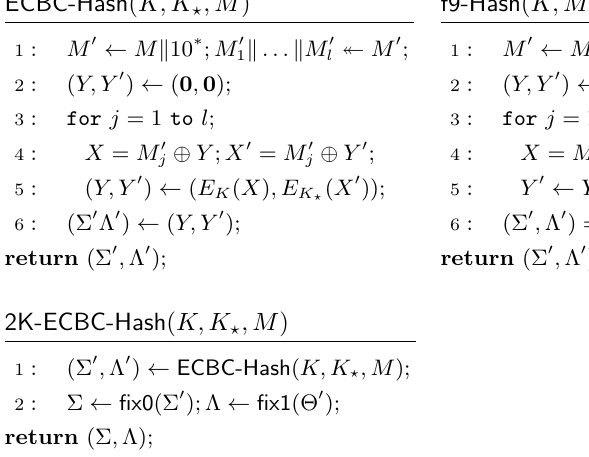
(cid:17) M 0 k . . . k M 0 1 l